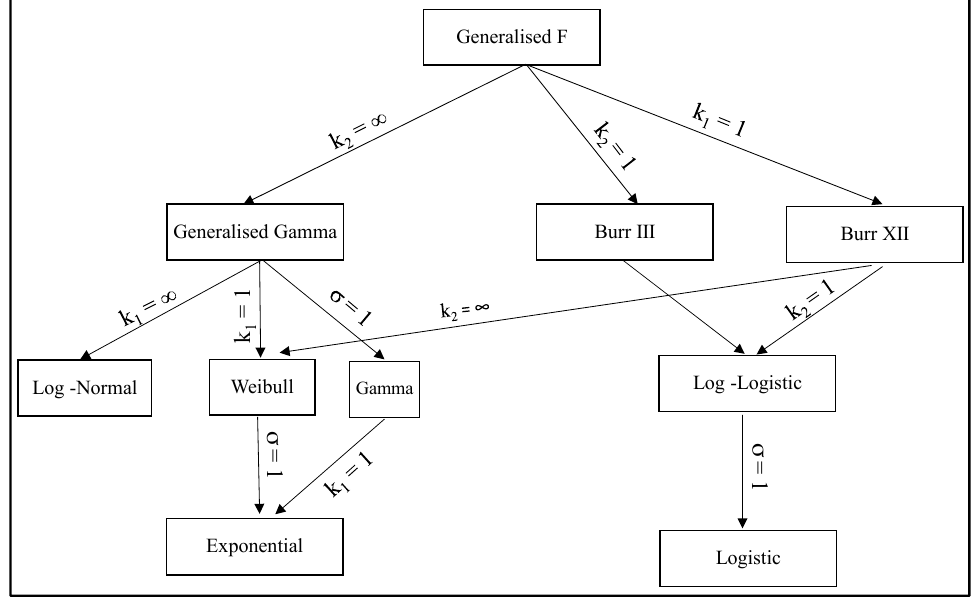
Figure 3. Members of the Generalised F distribution.